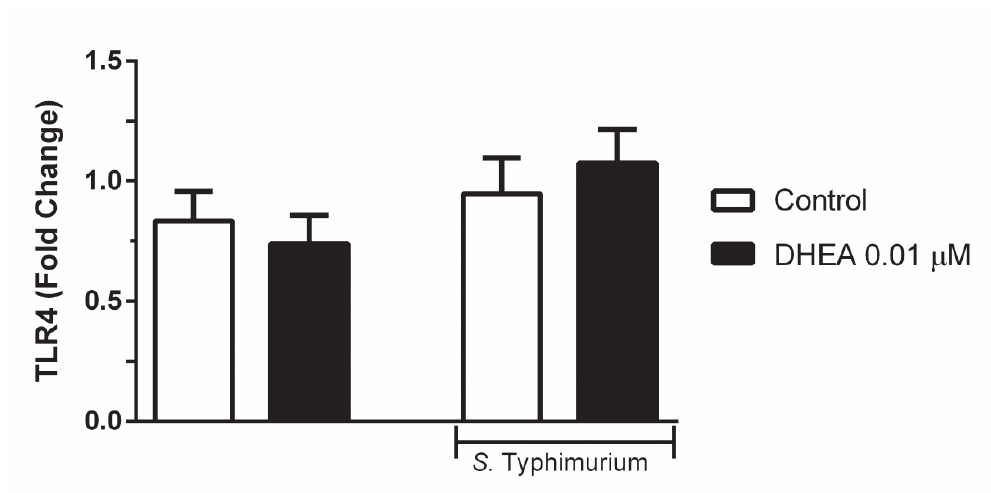
FIGURE 4 – DHEA treatment did not not modulate the expression of TLR4 by neutrophils. Neutrophils (1 x 10 6 ) were treated with the concentration 0.01 µM of DHEA for 1 hour, then were infected with S. Typhimurium (MOI = 10) for one hour. Data express the Mean (SD) of fold change expression of TLR4 relative to the ACTB house-keeping gene analyzed by Real-time